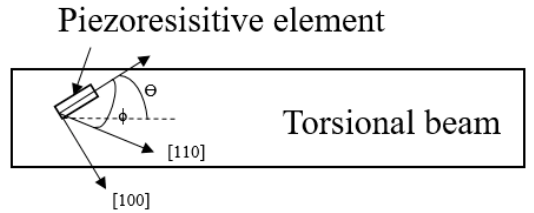
Figure 2. Torsional beam and piezoresistive element on silicon(100) wafer.